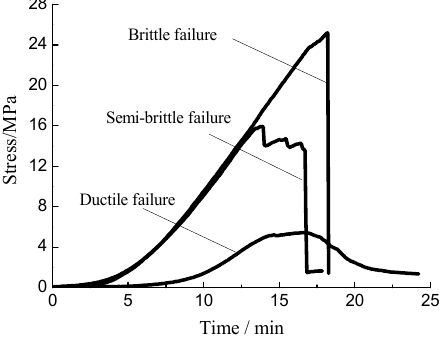
Figure 7. The typical stress curves of different failure types.